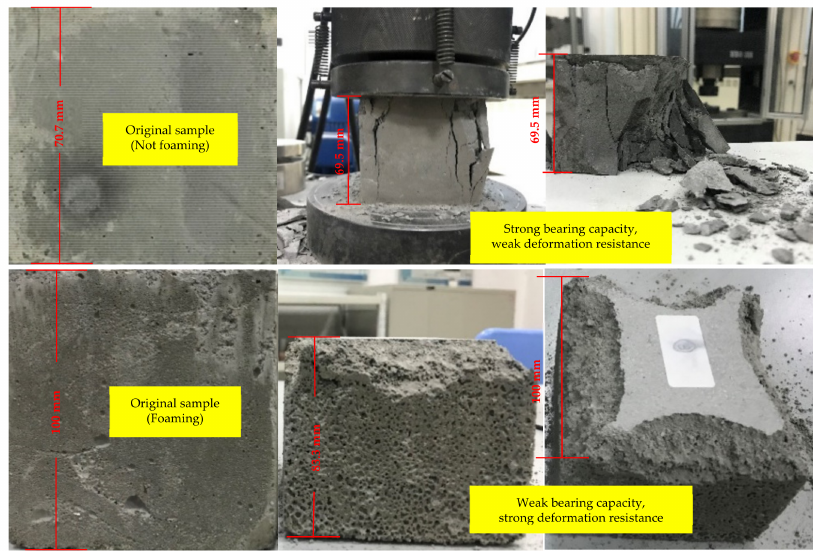
Figure 5. The deformation result of FBLPG and the matrix. Samples.